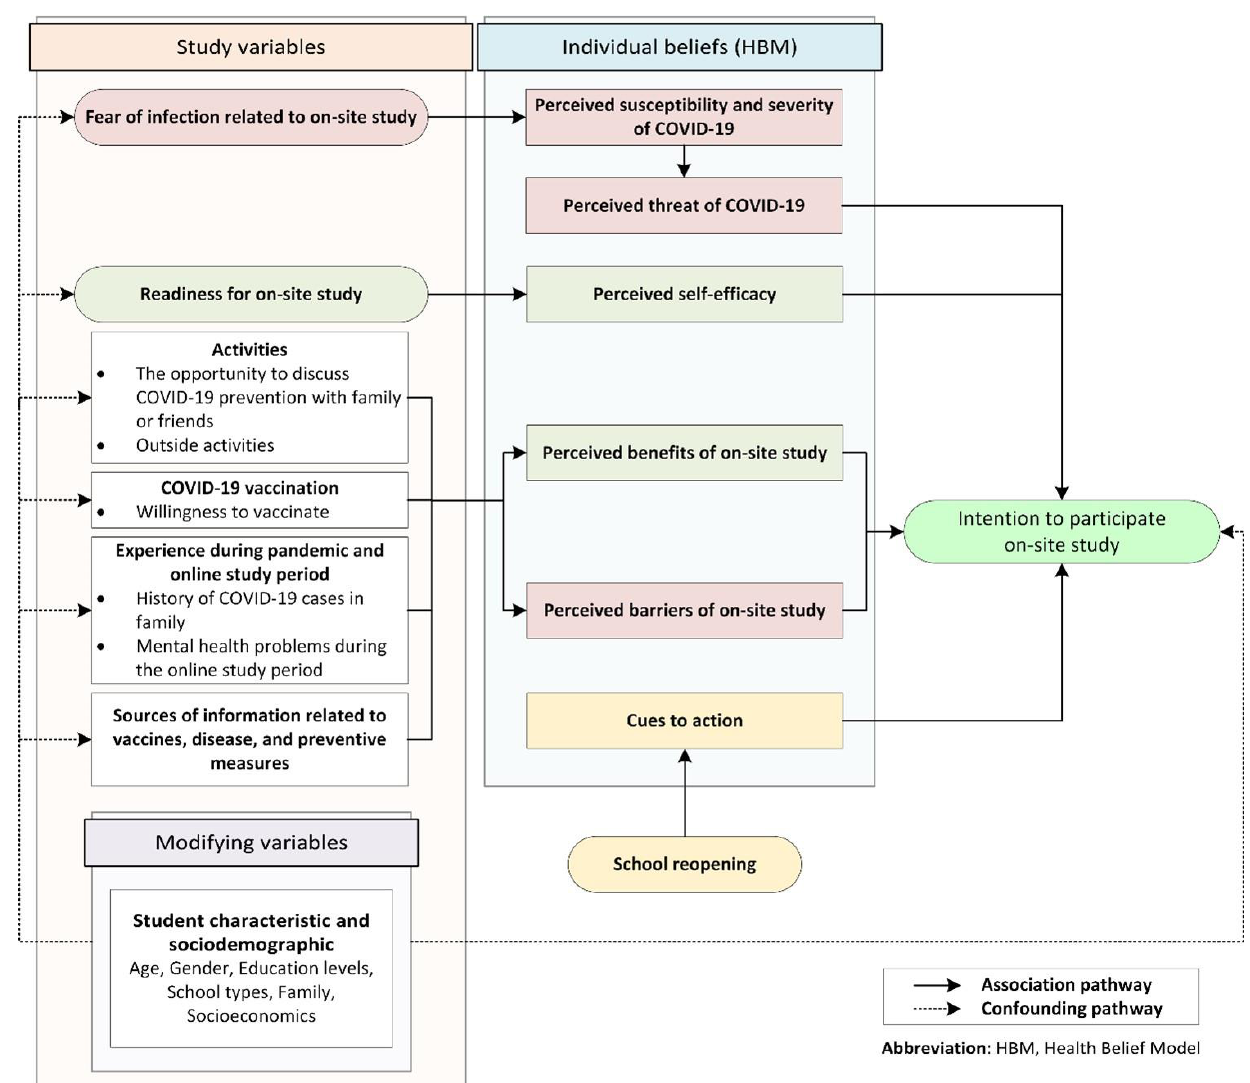
Figure 1. The conceptual framework of students ’ hesitancy to participate in on-site